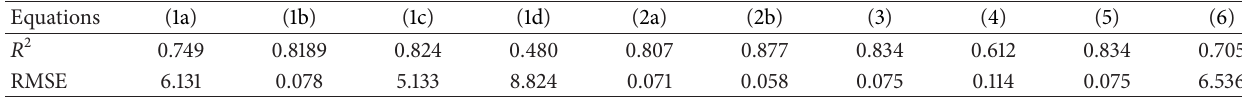
Table 4: 𝑅 -square and root mean square error (RMSE) of the equations to